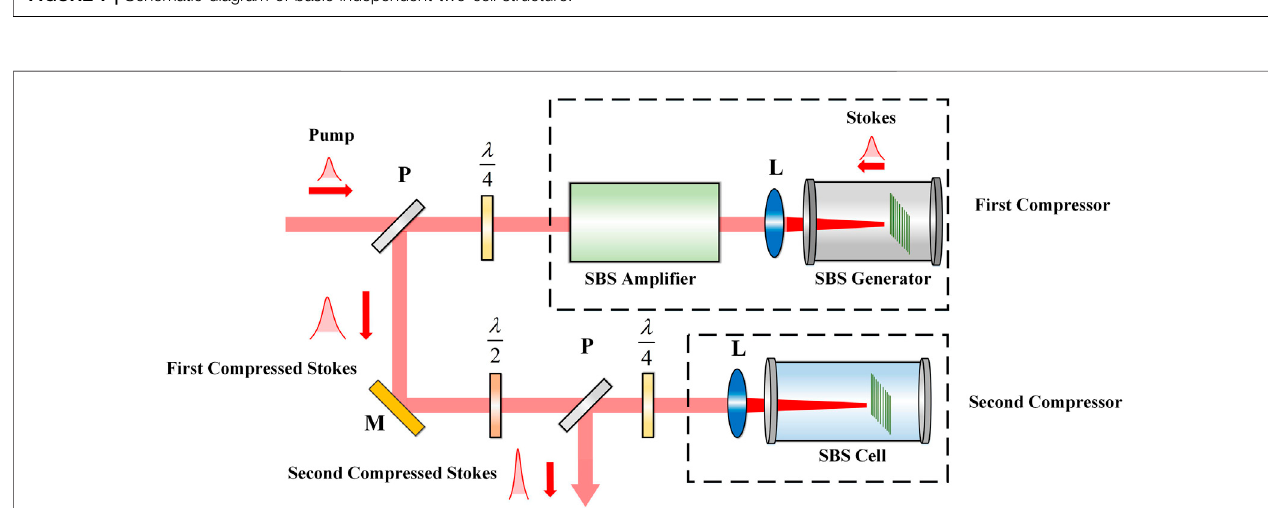
FIGURE 8 | Schematic of the two-stage compression structure.